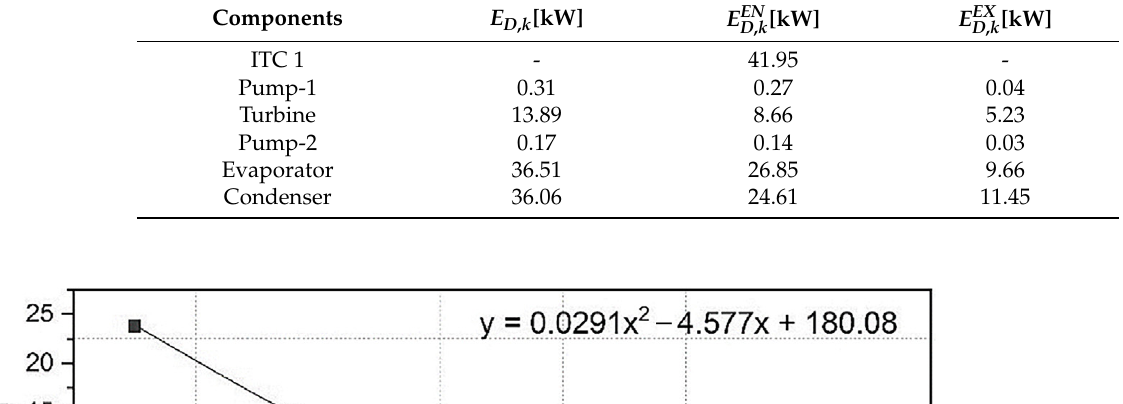
Table 10. Endogenous and exogenous exergy of each component destroyed.